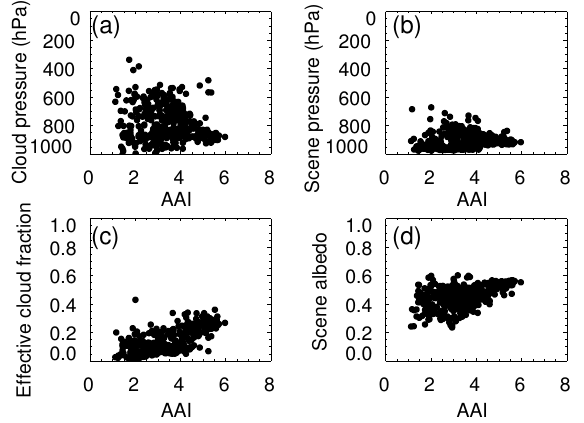
Fig. 15. Scatter plots of FRESCO (a) cloud pressure, (b) scene pres- sure, (c) effective cloud fraction, and (d) scene albedo versus ab- sorbing aerosol index (AAI) from GOME-2 measurements of the Saharan desert dust event on 30 June 2010 around 09:45UTC. The pixels used in the scatter plots are marked with a box in Fig. 14 in the region of [20, 26] ◦ N and [ − 5, 10] ◦